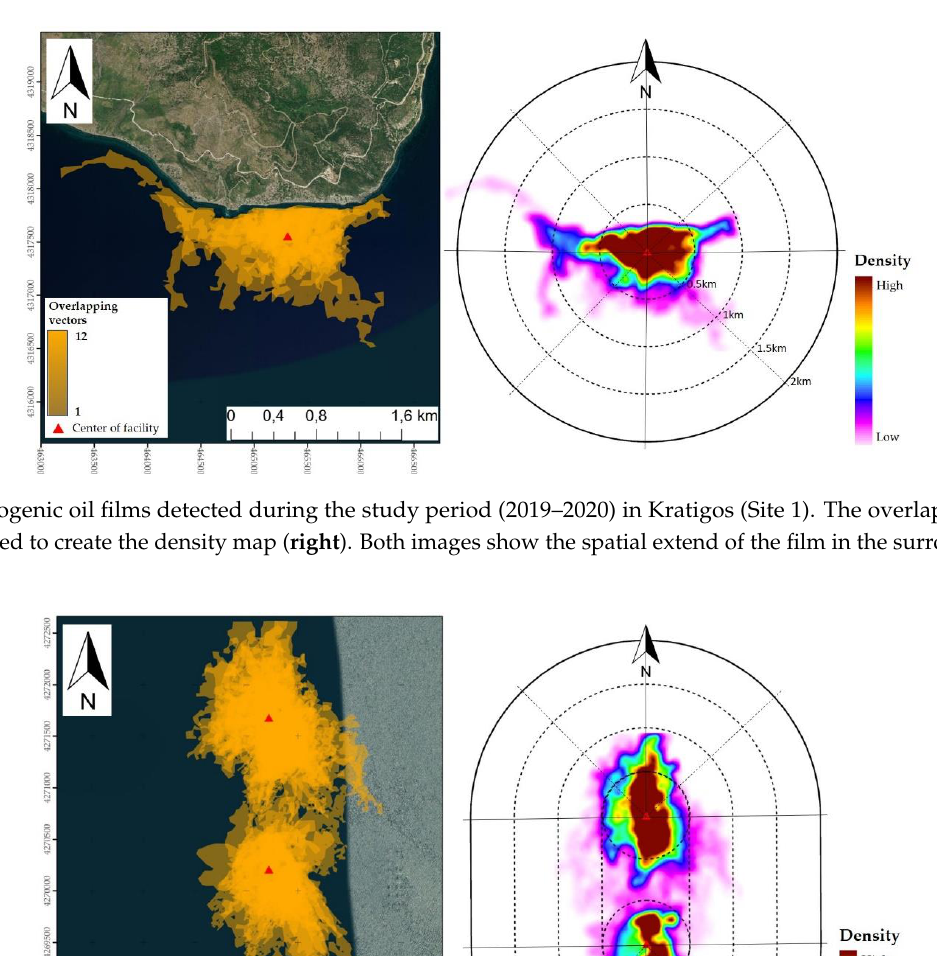
Error! Reference source not found. – Error! Reference source not found. present the 306